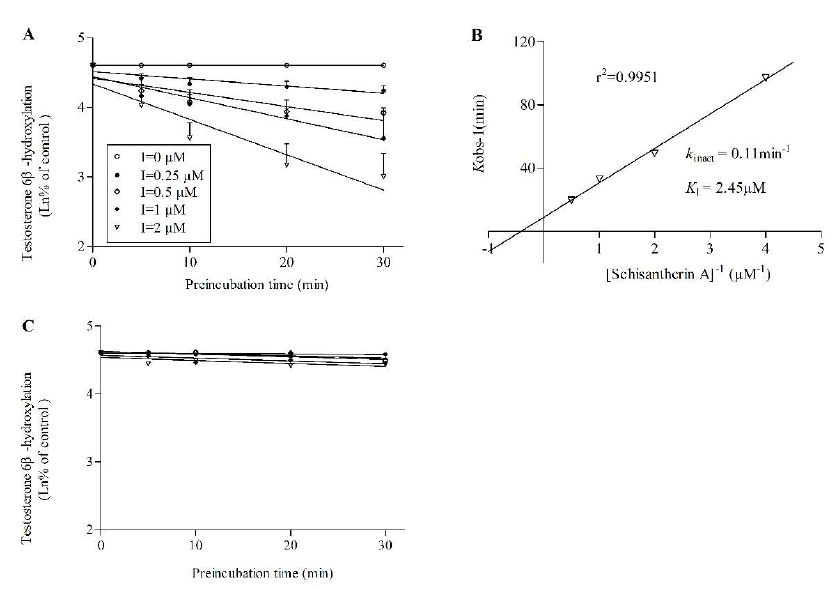
Figure 3. Inactivation of CYP3A4 ( A , B ) and CYP3A5( C ) activity by STA. Various concentrations of STA (0, 0.25, 0.5, 1, 2 µ M) and NADPH (Nicotinamide Adenine Dinucleotide Phosphate) at were preincubated at 37 ◦ C for 0, 5, 10, 20 and 30 min in 0.1 M phosphate buffer solution (PBS). ( A , C ) a plot of the log of percentage of control activity versus pre-incubation time. ( B ) a plot of the half-life of enzyme inactivation versus the inverse of the STA concentration. Each point represents the average of triplicate experiments (mean and SD values are listed in Table S1).